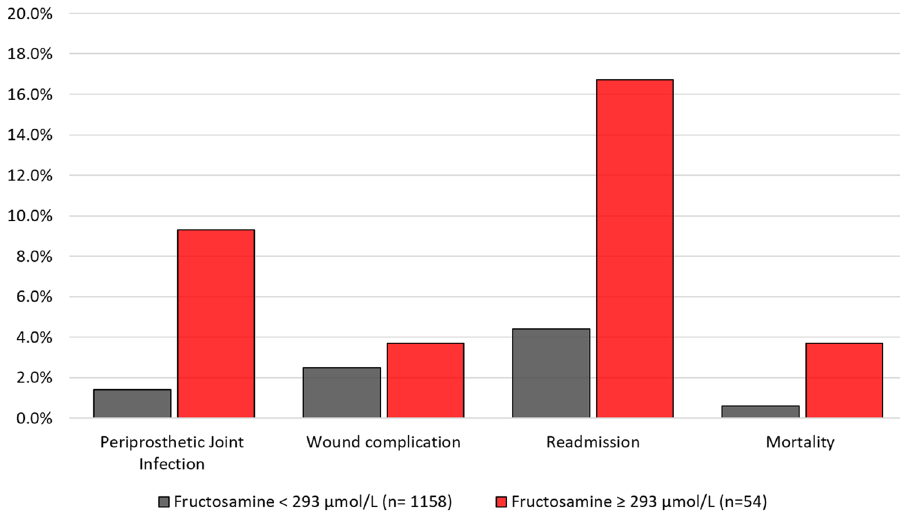
Figure 2. Complication rates stratified based on fructosamine levels below 293 μmol/L (n = 1158) and above 293 μmol/L (n = 54). *Represents statistically significant differences.